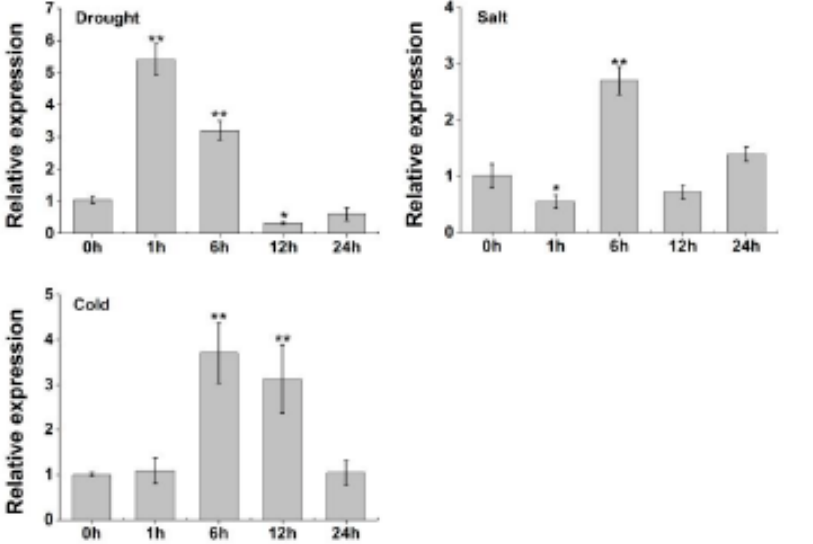
Figure 8. Expression patterns of TaERF-6-3A in response to conditions of drought (20% PEG6000), salt (200 mM NaCl), and cold (4 °C) as analyzed by qRT-PCR. Standard deviations are indicated by error bars (mean ± SD and n = 3), and significant differences are indicated using asterisks (ANOVA, * p < 0.05; ** p < 0.01).